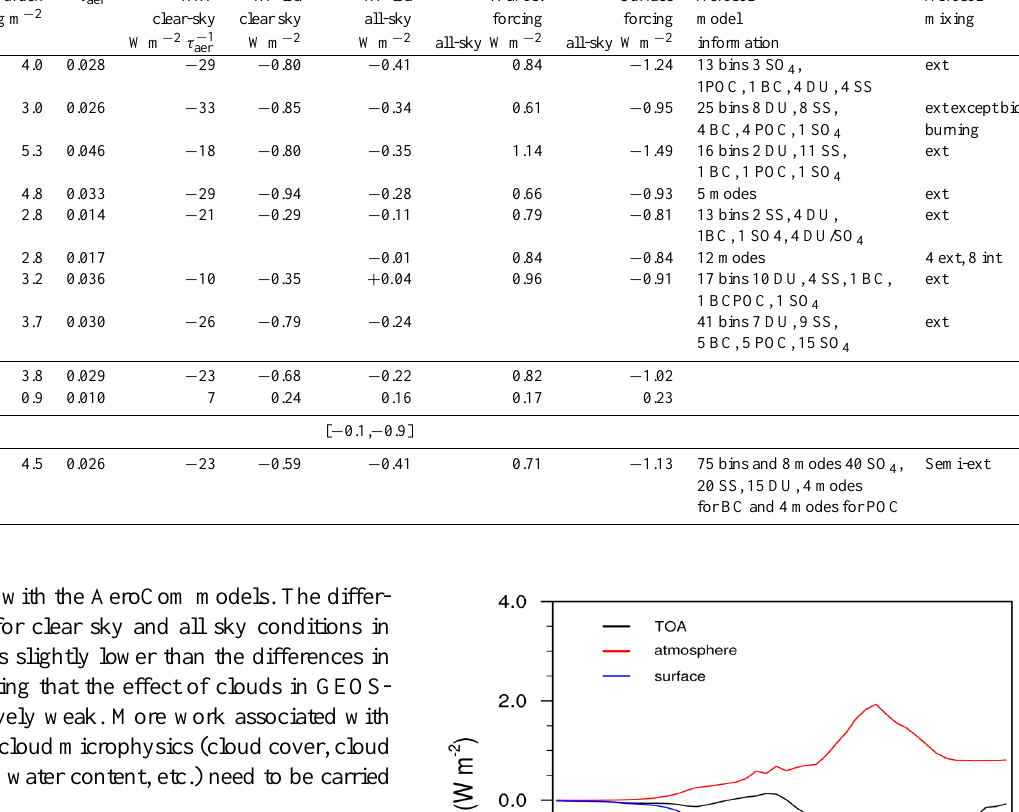
Table 7. Simulations from GEOS-Chem-APM and AeroCom models, and results in IPCC (2007) for anthropogenic aerosol burden, optical depth ( τ aer ) , the normalized RF per unit optical depth (NRF) for clear-sky. The aerosol direct raidative forcing at top of atmosphere (TOA) and surface and atmoshphere are given for al-sky conditions. Aerosol model information (bin or modal) and mixing state are also given in the table. The results from AeroCom are taken from Table 5 in Schulz et al. (2006). Model Burden